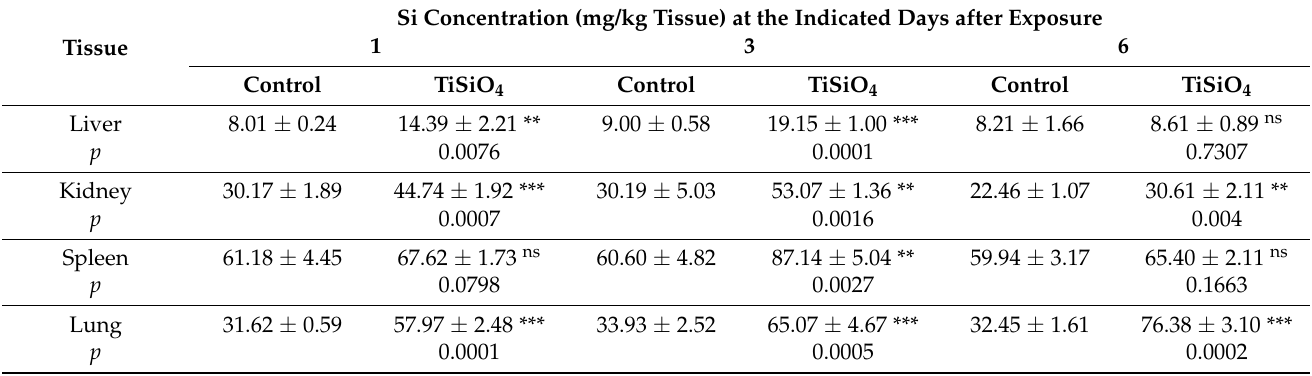
Table 6. Silica content (mg/kg tissue) in male rat liver, kidney, and spleen tissues 1, 3, and 6 days post-oral administration of 250 mg ≤ 50 nm TiSiO 4 NPs/kg b.w.